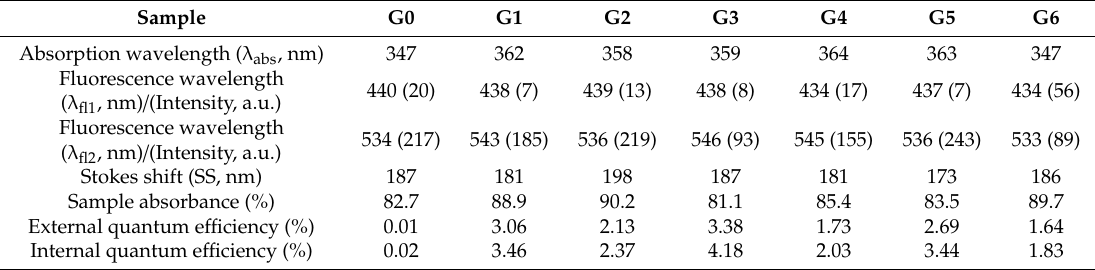
Table 2. Photophysical characteristics of SAA (1% by weight) embedded in hybrid films. Sample G0